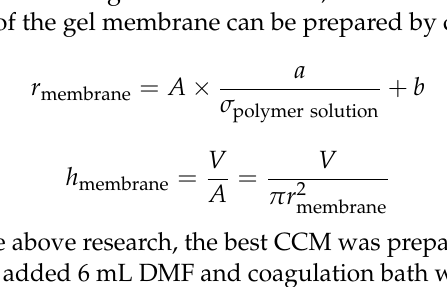
Figure 3. Digital photos of cellulose/CNTs mixed polymer solution added 6 mL DMF dropped into coagulating bath with DMF/water (volume ratio = 1/1) taken by high-speed camera. By the measurement of the gel membrane size, the formula is obtained by